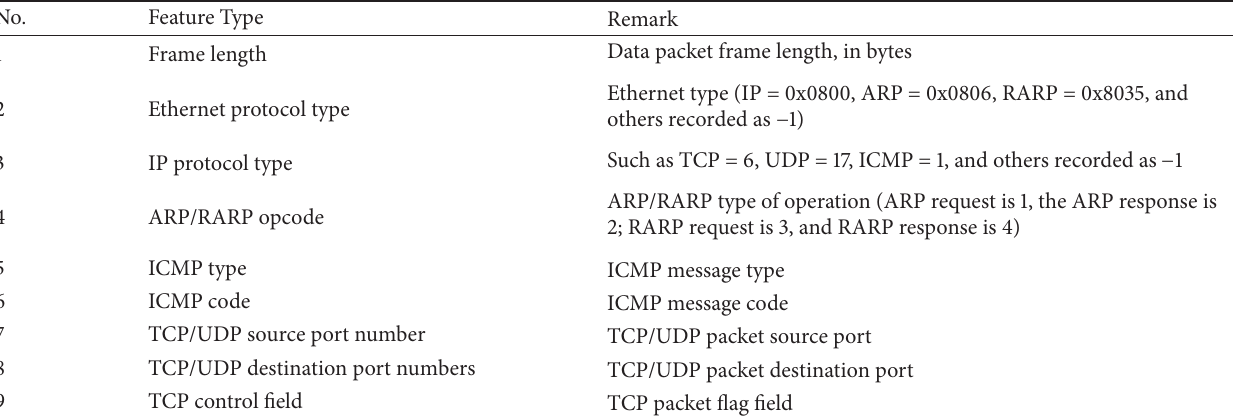
Figure 7: Parse packets result from Wireshark. Table 1: Specific features selected for this